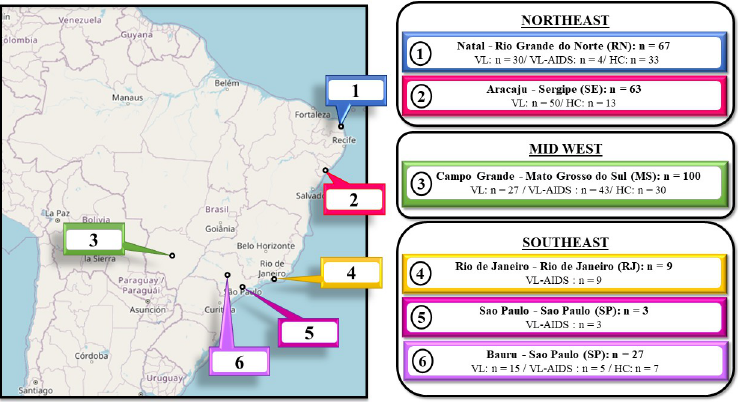
Fig 1. Patients and healthy controls from different geographical regions in Brazil. Samples were collected from 122 VL patients, 64 VL-AIDS patients, and 83 healthy individuals living in endemic areas. n—number of samples; VL— visceral leishmaniasis; VL-AIDS—co-infection; HC—healthy controls. The base map was obtained from https://apps.